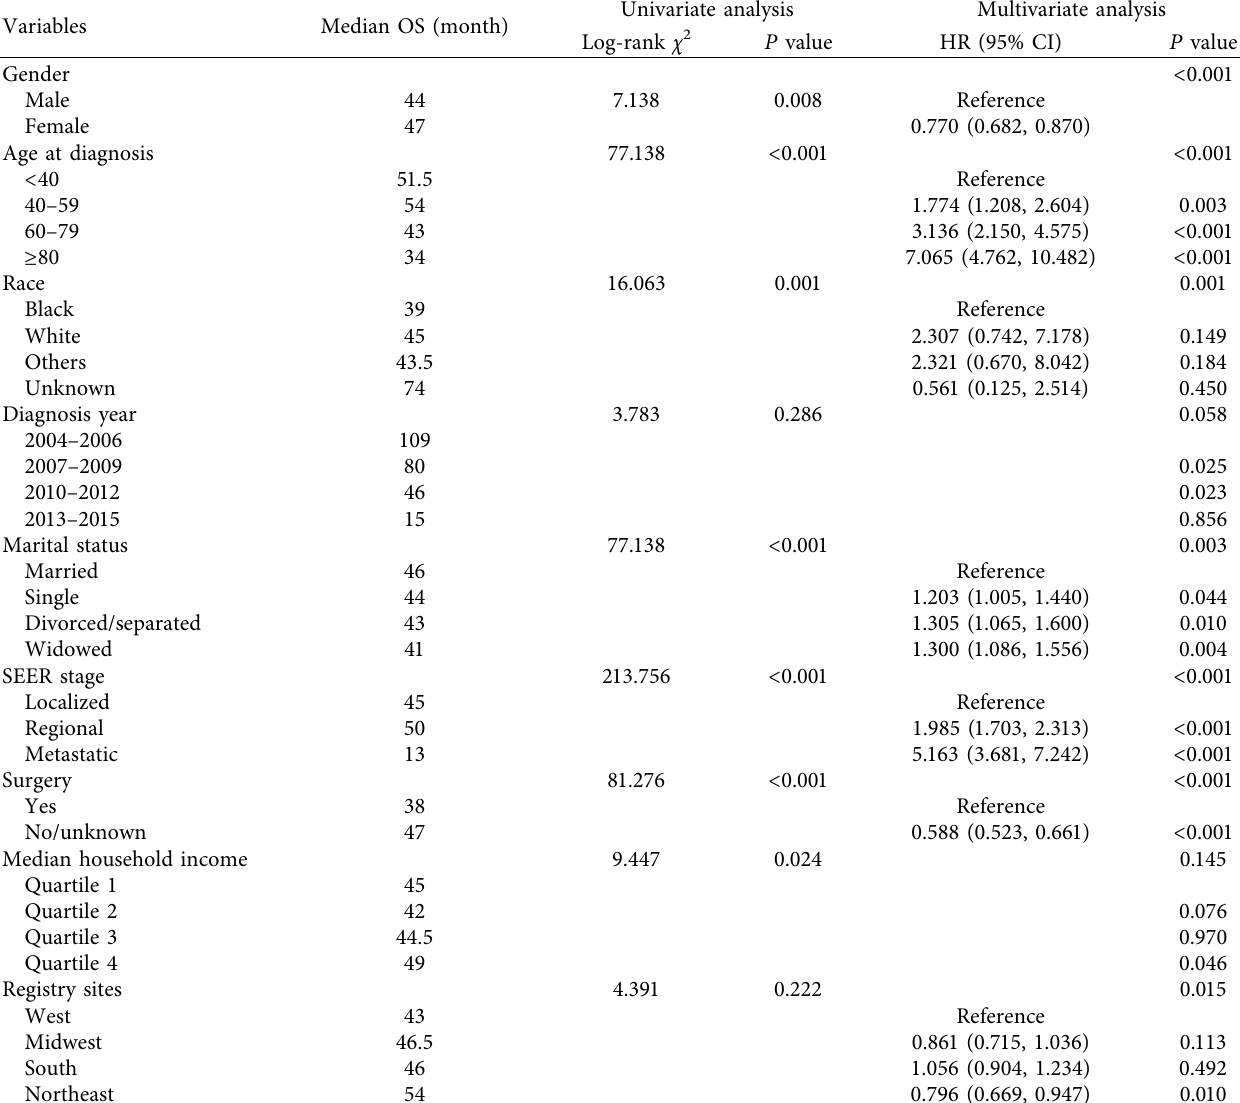
Table 2: Univariate and multivariate analysis for OS in uveal melanoma